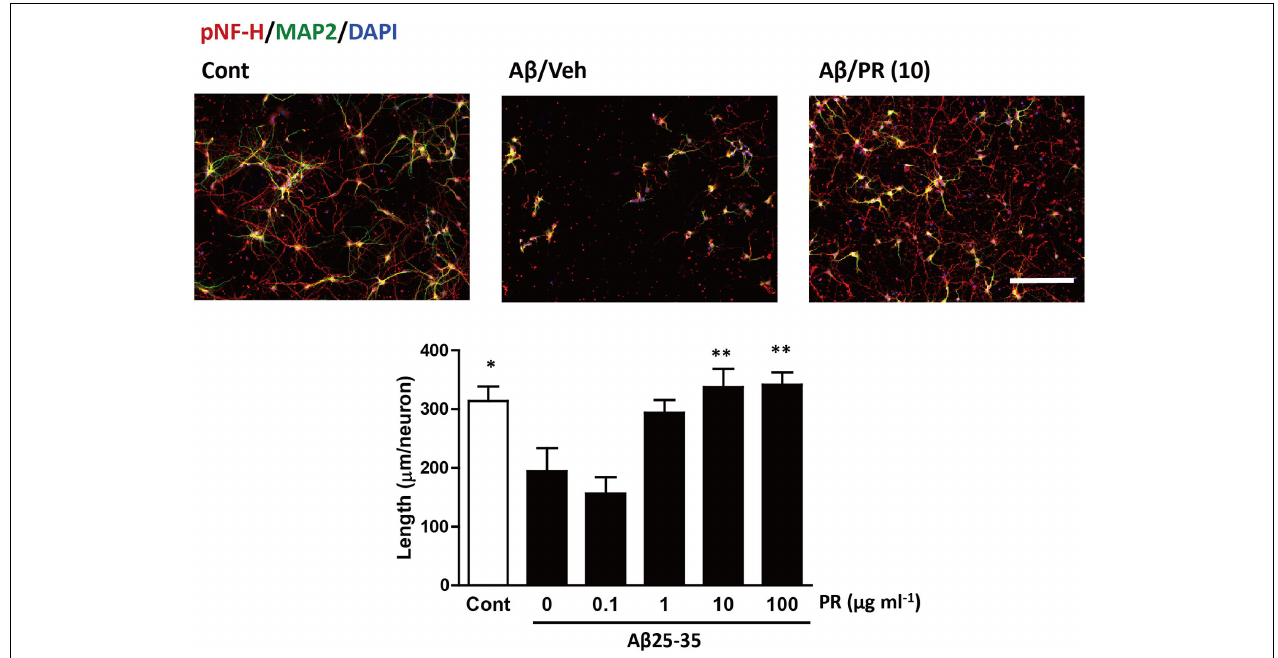
FIGURE 5 | Effects of Polygalae Radix (PR) extract on amyloid β (A β )-induced axonal atrophy. Cortical neurons were cultured for 3 days and treated simultaneously with vehicle solution (Cont) or A β 25–35 (10 µ M), and vehicle solution (Cont, 0 µ g ml − 1 ) or PR extract (at doses of 0.1, 1, 10, or 100 µ g ml − 1 ) for 4 days. Thereafter, the neurons were fixed and immunostained for phosphorylated neurofilament-H (pNF-H, an axonal marker, red) and microtubule associated protein 2 (MAP2, a neuronal marker, green). DAPI (blue) was used for counterstaining. Representative fluorescence images are shown (upper) . Scale bar, 200 µ m. The total axonal length per neuron were quantified. The mean values of the data are presented together with the standard error (lower) . ∗∗ P < 0.01 vs. 0 µ g/mL PR + A β 25–35; Bonferroni’s multiple comparison test, n = 10